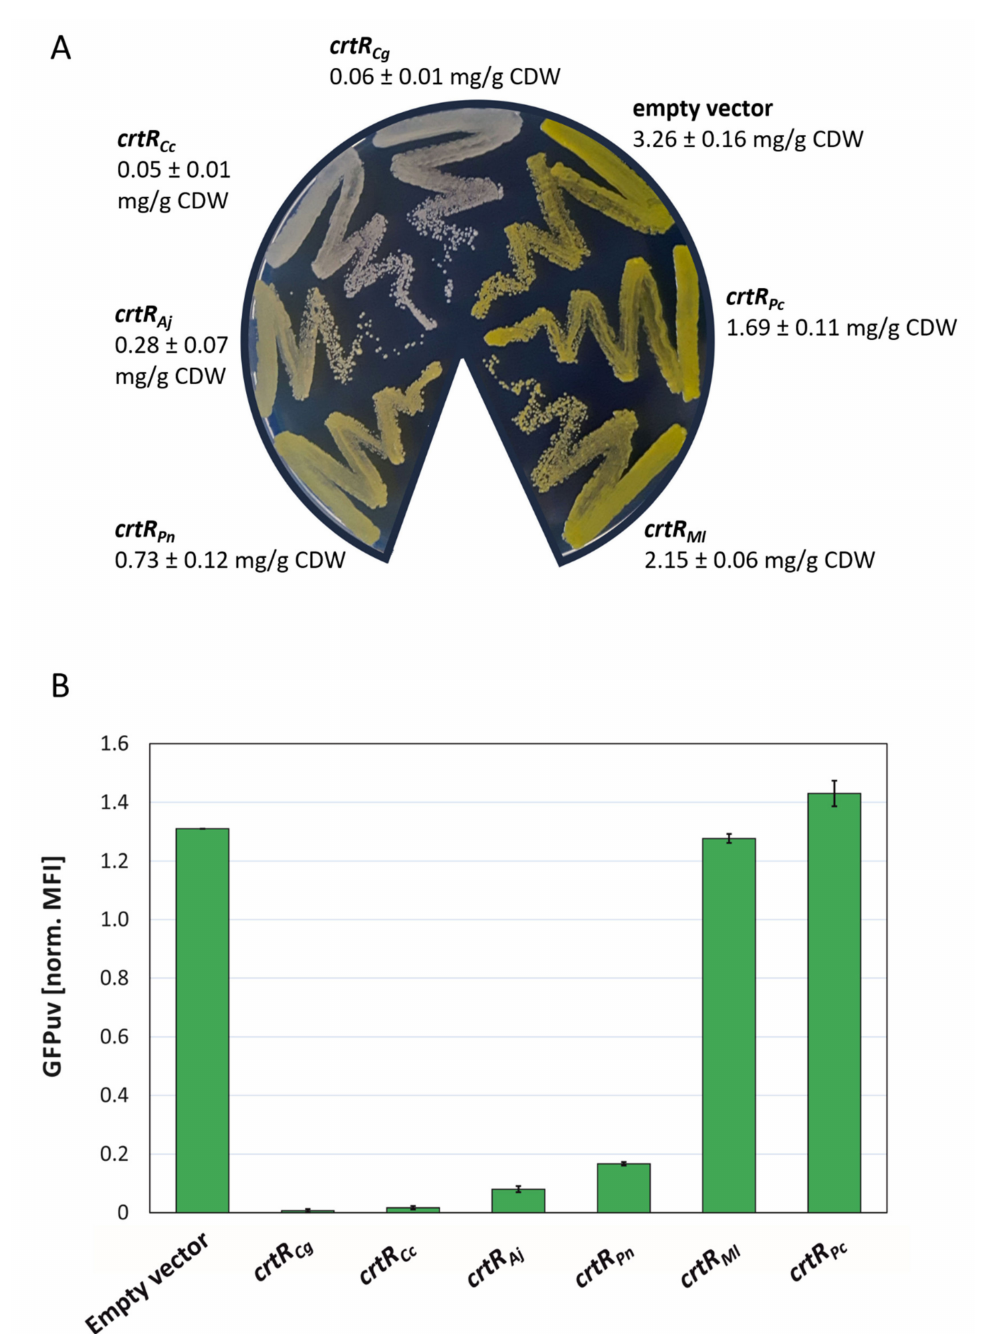
Figure 4. In vivo characterization of CrtR orthologs in C. glutamicum WT ∆ crtR . ( A ) Phenotypes on LB plates after incubation at 30 ◦ C for 24 h and carotenoid concentration in mg / g CDW ( β -carotene equivalents) of WT ∆ crtR strains harboring pTEST derivatives expressing crtR genes from the indicated bacteria. ( B ) Flow cytometry analysis of the strains depicted in (A) during exponential growth in LB. Mean fluorescence intensities (MFI) of GFPuv signals were normalized to autofluorescence and shown for at least two biological